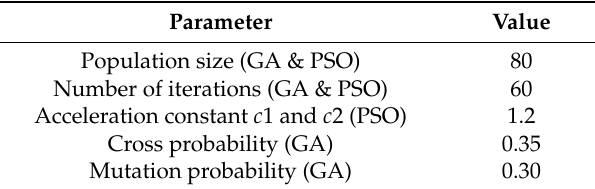
Table 2. Related parameters of the PSO algorithm and GA algorithm.